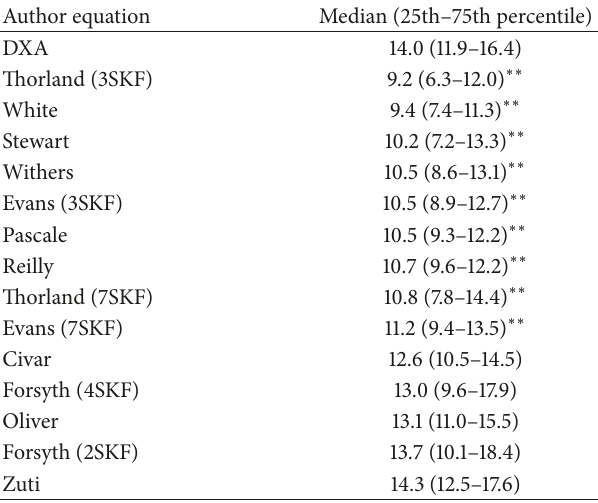
Table 4: Body fat percentage measured with DXA and estimated with anthropometric equations developed in athletic